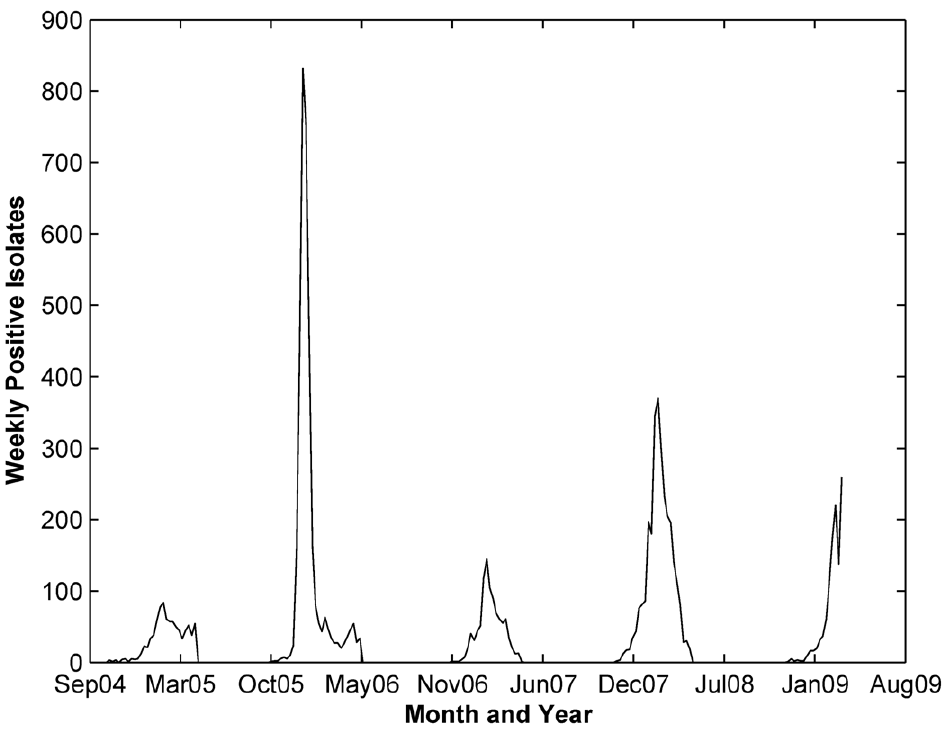
Figure 4. Maricopa county influenza cases.